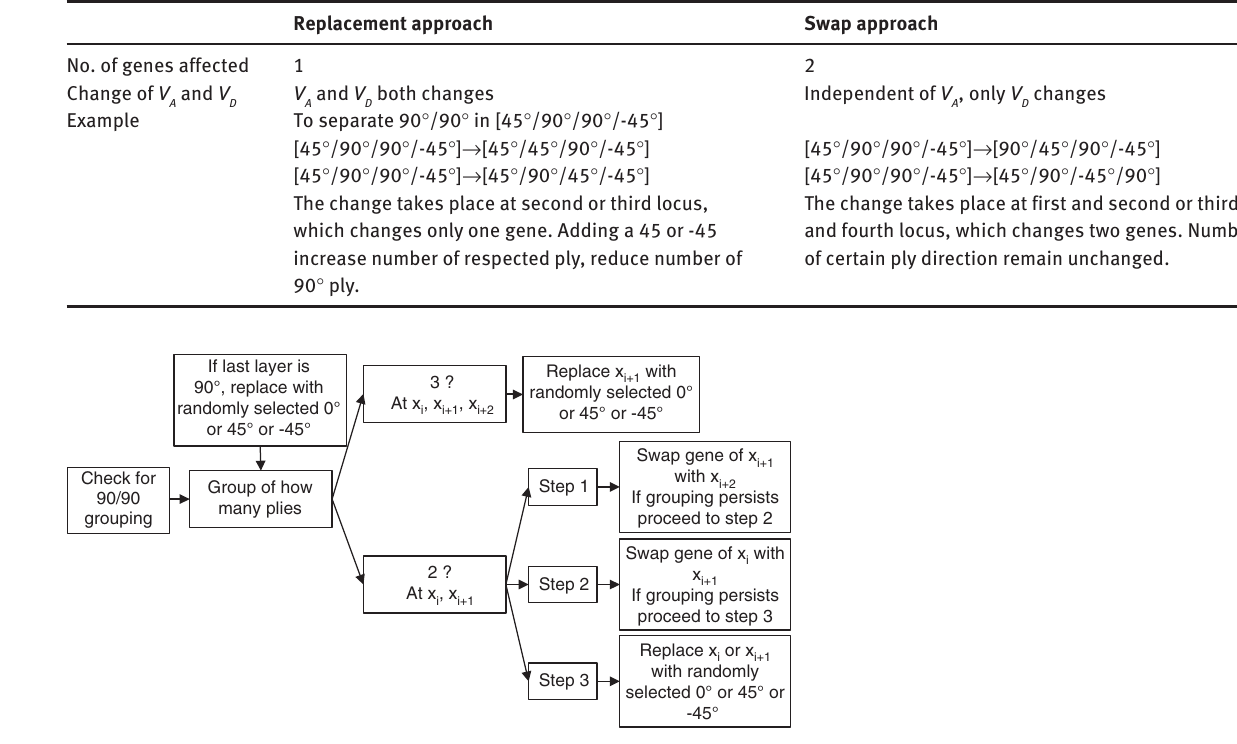
Figure 5 Execution process of combined approach for rule 5.